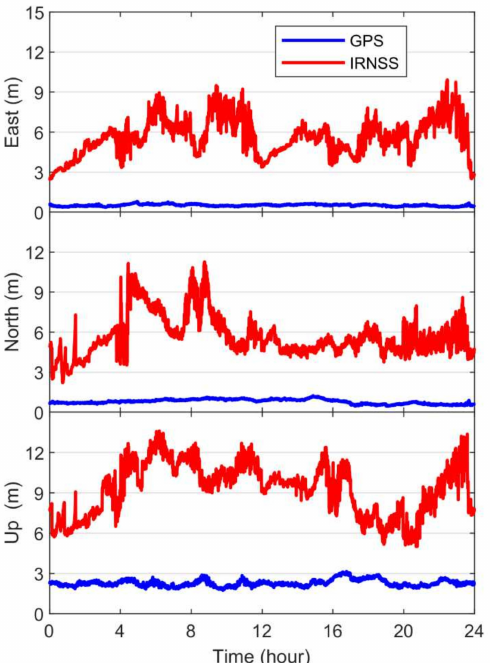
Figure 9. Epoch-wise RMS statistics of positioning errors in the east, north and up directions for IRNSS-only and GPS-only SPP based on the datasets collected at 14 MGEX stations on 7–13 July